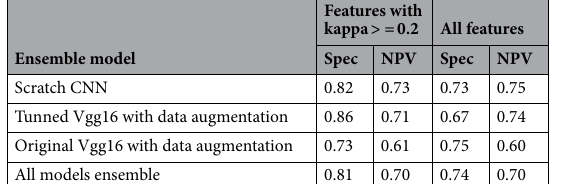
Features with kappa > = 0.2 Ensemble model Scratch CNN Tunned Vgg16 with data augmentation 0.76 Original Vgg16 with data Augmentation 0.63 All models ensemble Table 9. The performance of ensemble model classification for the features with kappa > = 0.2 and all the features (ACC, Prec, Recall, F1, kappa). Bold values indicate best performance of the classifiers.